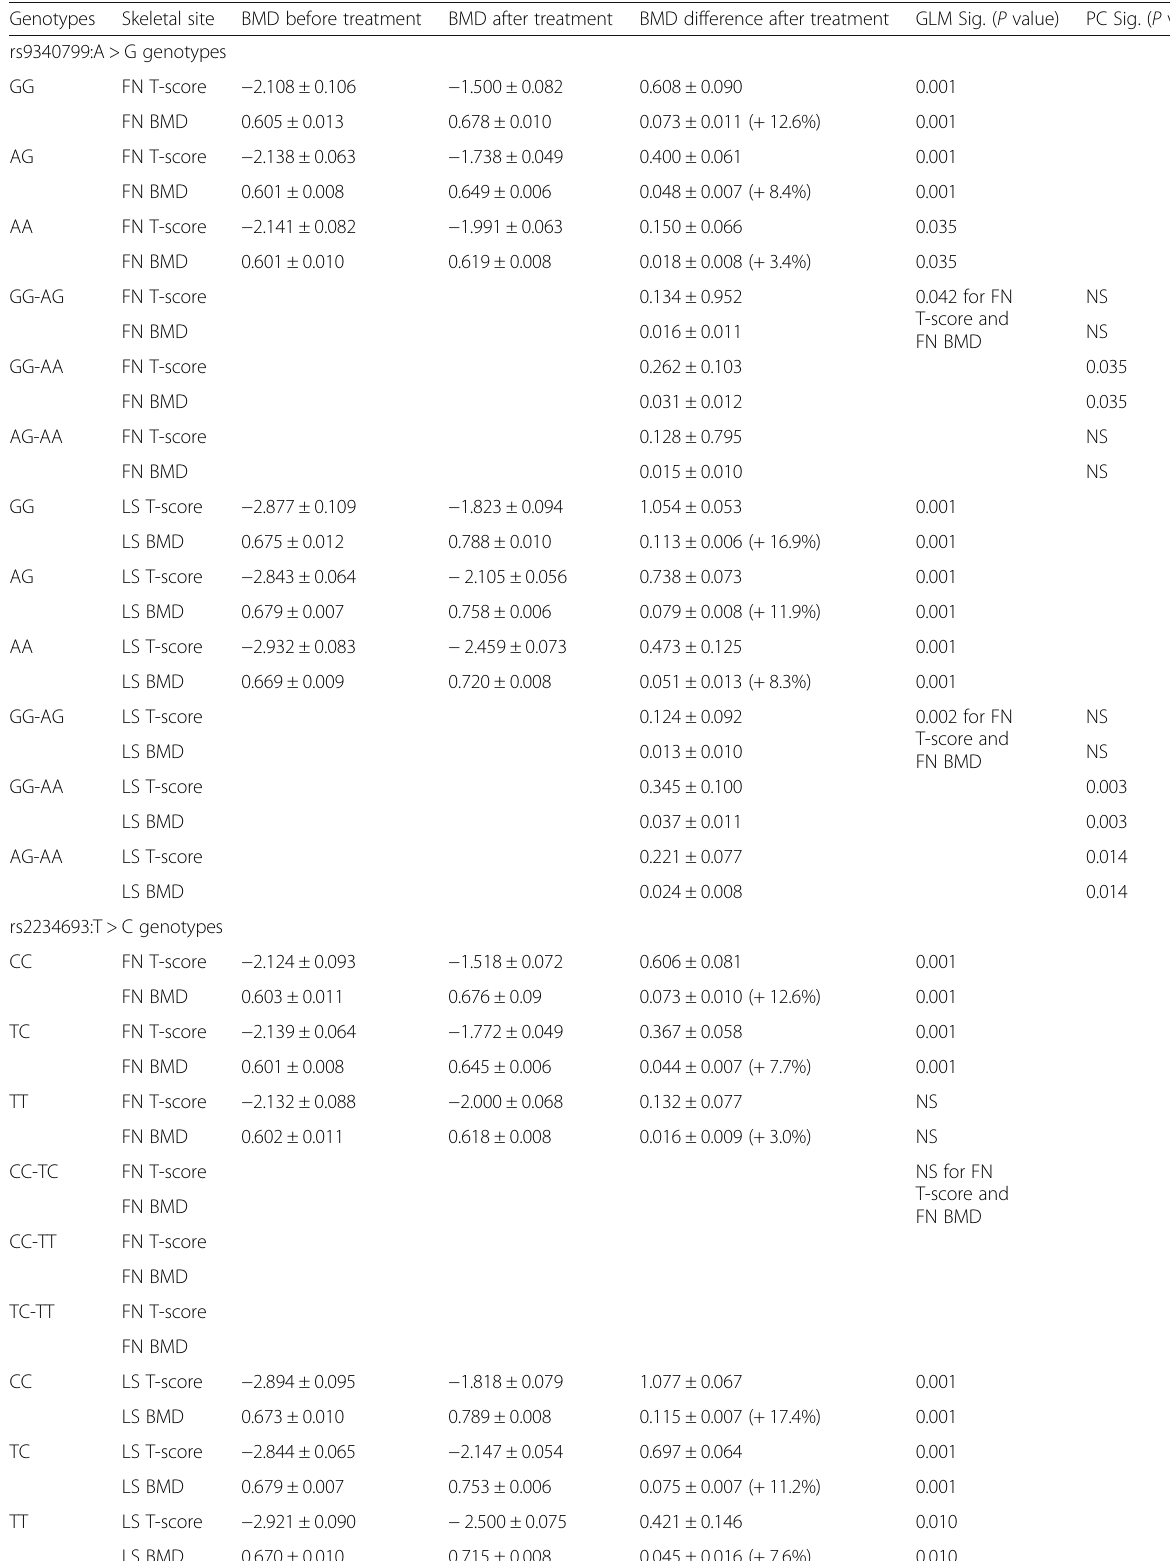
Table 6 BMD changes after hormone therapy in relation to the rs9340799 and rs2234693